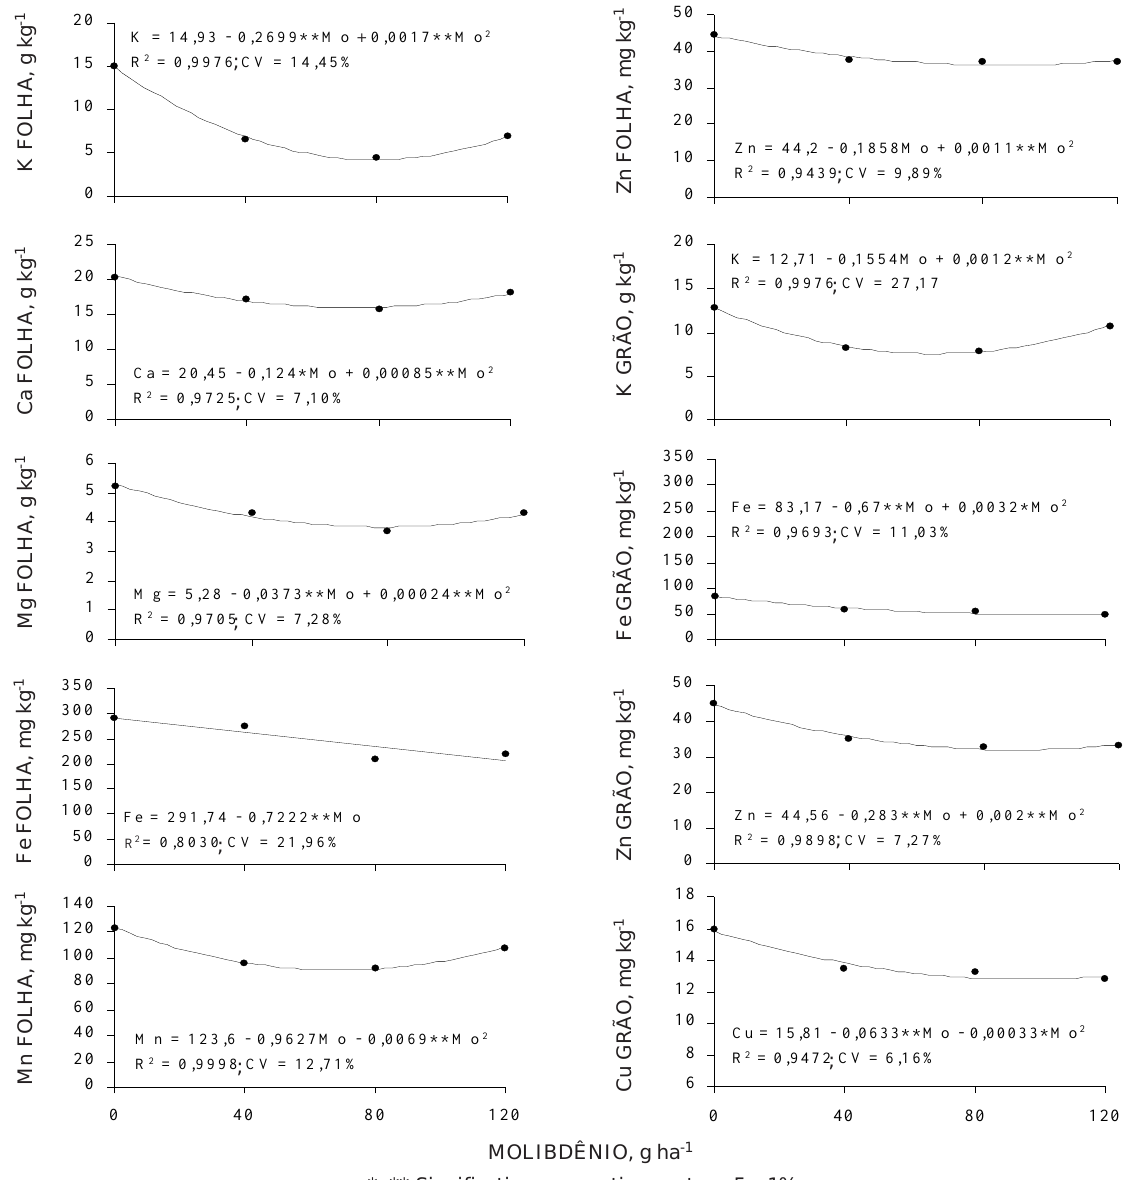
Figura 3. Teor de nutrientes nas folhas e nos grãos do feijoeiro cv. Ouro Negro, cultivado no outono- inverno de 1996, em função da adubação foliar com